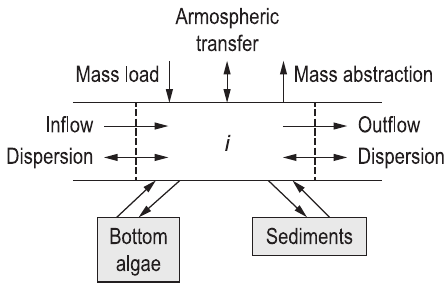
Figure 3. Mass-balance in a reach segment I (adapted from Pelletier and Chapra,